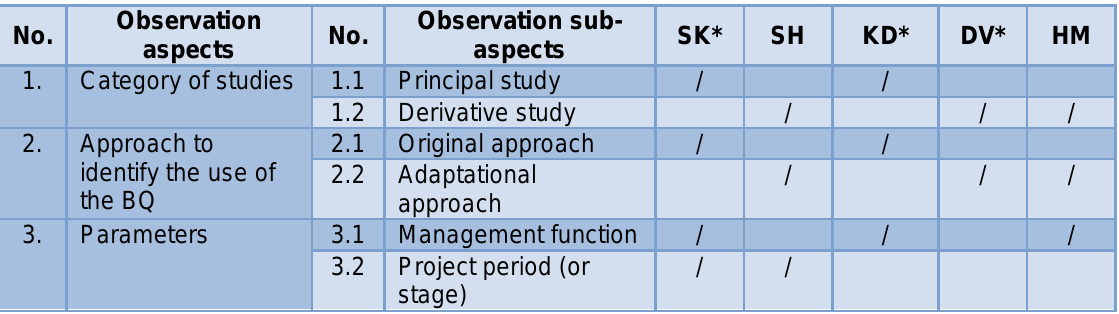
Table 3 Observations from past studies on the use of BQ to contracting organisations * - refer to combined studies. SK* = Skinner (1979, 1980); SH = Smith and Hoong (1985); KD* = Kodikara (1990), Kodikara , et al. (1993); DV* = Davis and Baccarini (2004), Davis , et al. (2009); HM = Hamimah , et al.